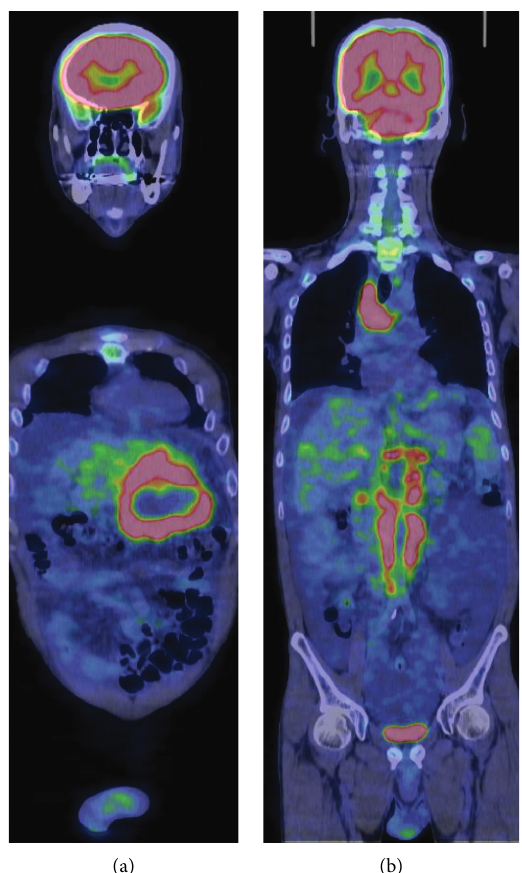
Figure 3: Fluorodeoxyglucose positron emission tomography scan showing significant accumulation in the left lobe and multiple hot spots in the paraaortic region.